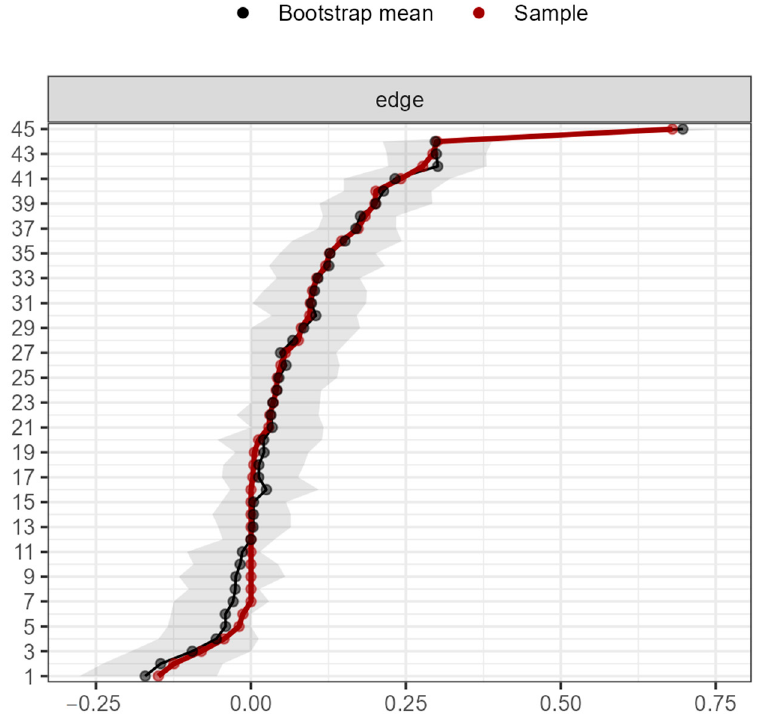
Figure A8. Precision in the estimation of the edges (red line, in the order of the highest to the lowest), and the 95% confidence interval of the estimates (gray line) for the network in the ‘always’ moment, estimated with the non-parametric bootstrap